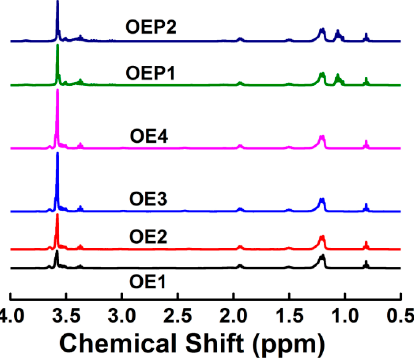
Figure 3. 1 H-NMR spectra of the prepared defoamers.